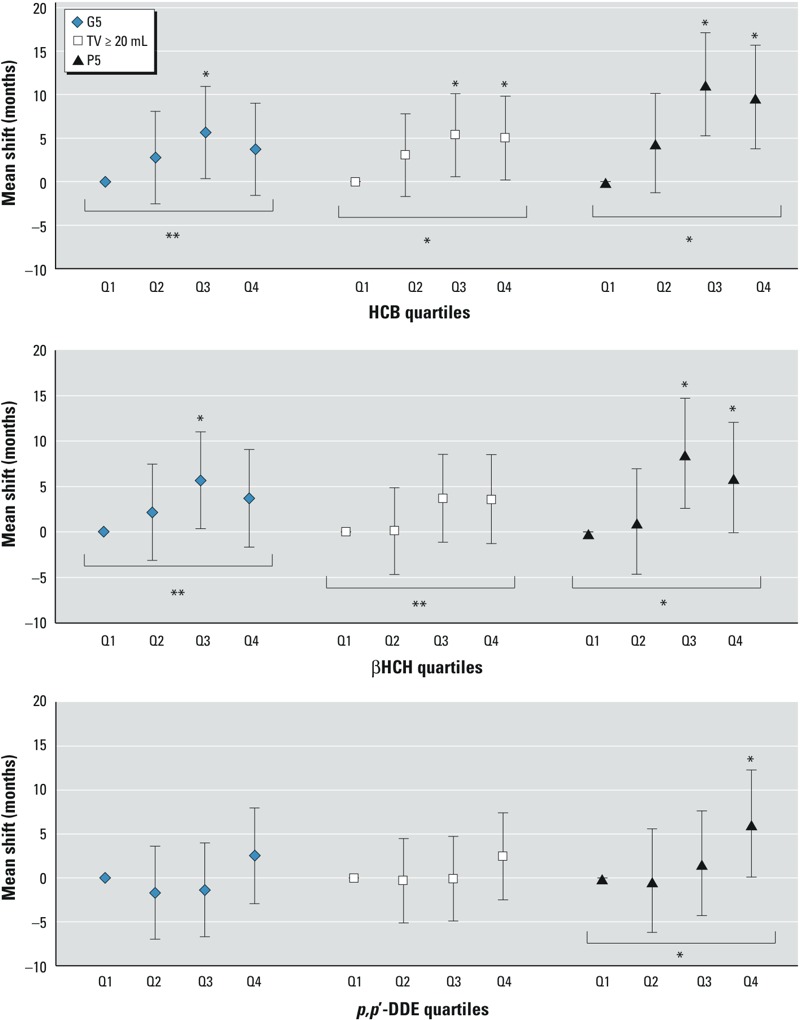
Adjusted mean shifts in age at sexual maturity (months, 95% CIs) by quartiles of wet-weight serum OCP concentrations among 350 Russian boys, relative to the lowest quartile (Q1). Baseline covariates for each model are as follows: G5: boy’s total serum lipids, macronutrients (total caloric intake, percent calories from dietary carbohydrates, fat, protein) (missing macronutrients, n = 3); TV ≥ 20 mL: boys’ total serum lipids, birth weight, blood lead levels, biological father’s absence from the household (missing birth weight, n = 1); P5: boys’ total serum lipids, biological father’s absence from the household. HCB wet-weight quartiles (pg/g serum): Q1, 169–516; Q2, 517–751; Q3, 752–1,156; Q4, 1,157–15,482. βHCH wet-weight quartiles (pg/g serum): Q1, 209–567; Q2, 568–814; Q3, 815–1,294; Q4, 1,295–13,732. p,p´-DDE wet-weight quartiles (pg/g serum): Q1, 261–907; Q2, 908–1,406; Q3, 1,407–2,327; Q4, 2,328–41,301.
*p ≤ 0.05. **p ≤ 0.10.